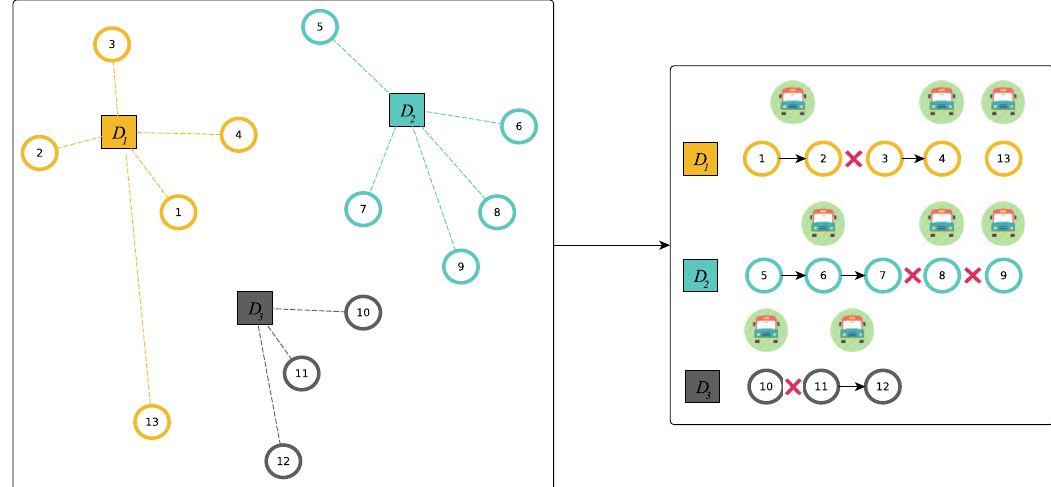
Fig. 4. Reassignment of trip 13 for fleet availability